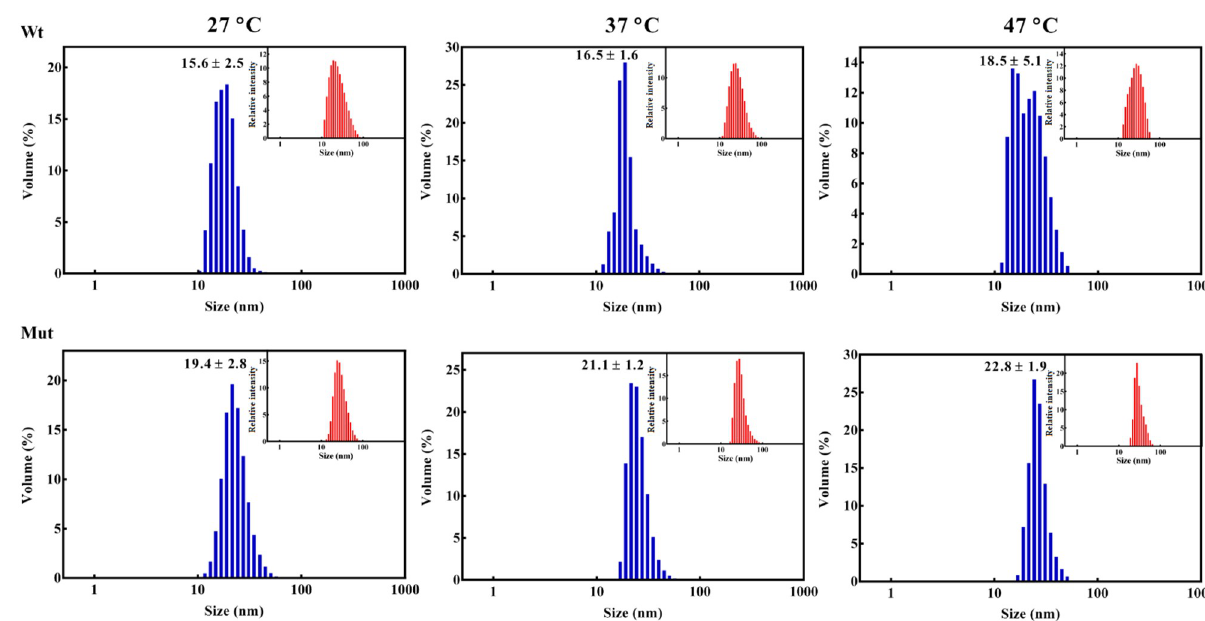
Fig 8. Study of the oligomerization state of different α B-crystallin samples. Dynamic light scattering studies on the protein samples (1 mg. mL -1 ) prepared in buffer A, at three different temperatures. The relative intensity versus size is shown as the inset figures.